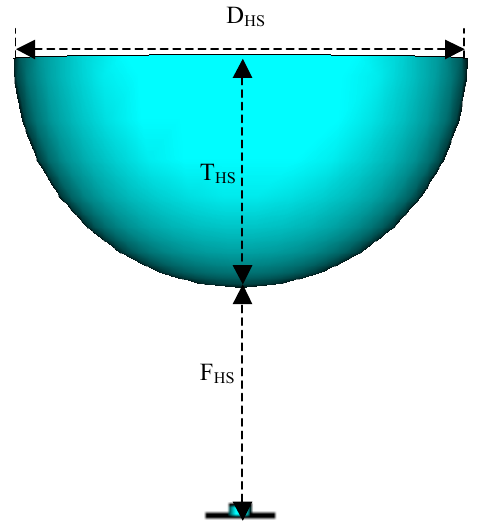
Figure 6: Geometry of a single DRA loaded with lower half dielectric sphere lens.